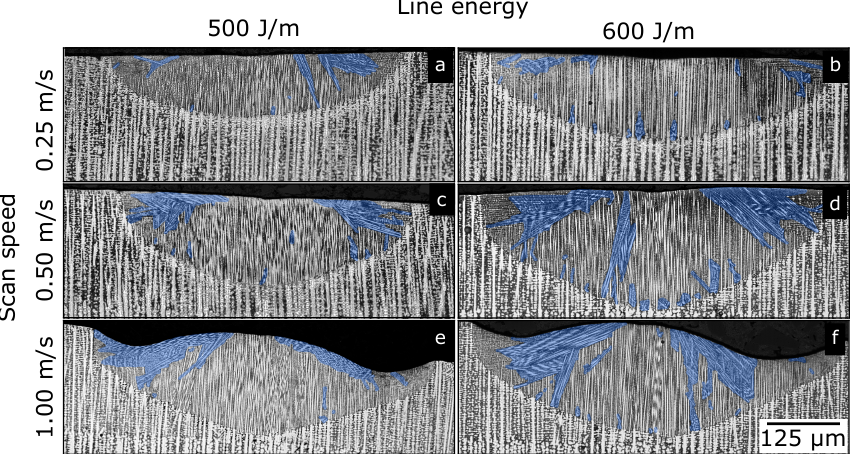
Figure 3. Exemplary microsections for different melting parameters ( a – f ) showing distinct evolution of new grains in single crystalline IN718 base material. For convenience, areas with new grains are highlighted in blue when their orientation was different from the base material. Proceeding grains from the base material are not